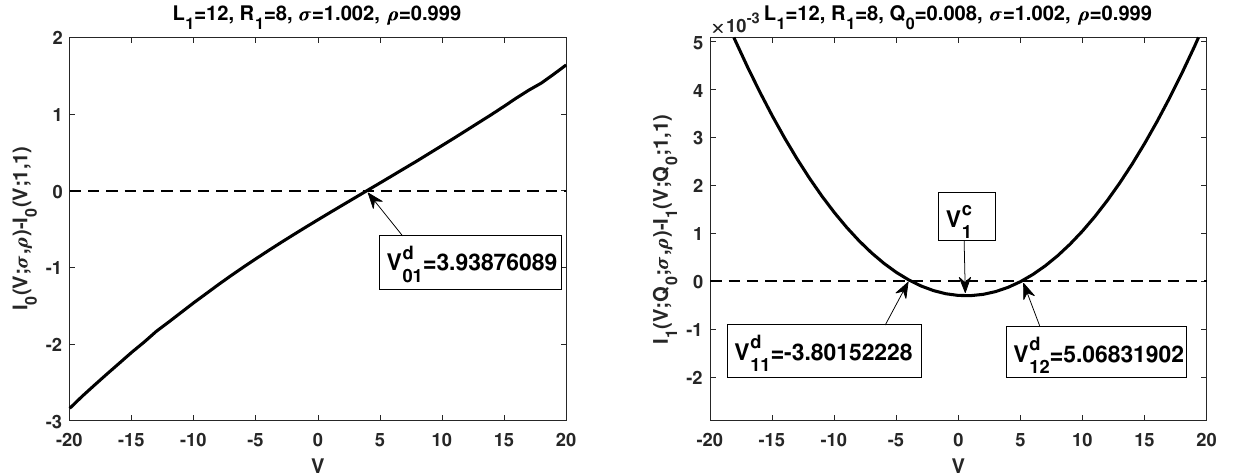
Figure 1. Numerical simulations for effects on I–V relations from boundary layers with small positive permanent charge.